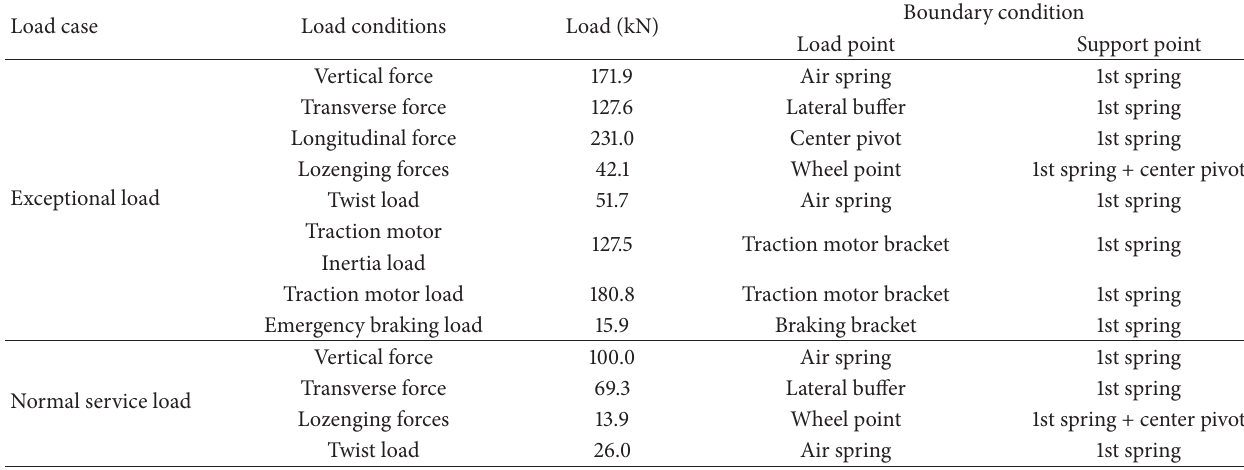
Figure 1: Driving bogie and finite element model. Table 1: Load case for static test.